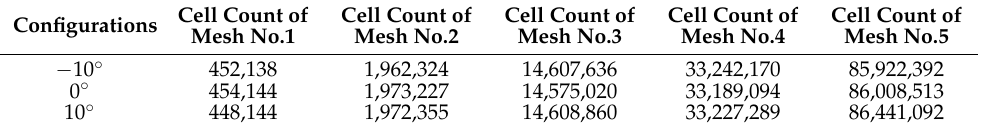
Table 4. Cell count of the five mesh schemes.